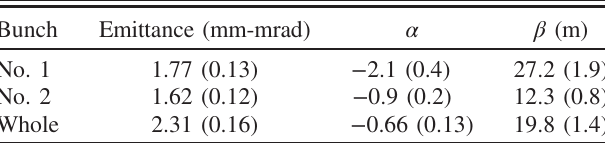
TABLE IV. Comparison of single bunch emittance measure- ment on screen U3 and D1.